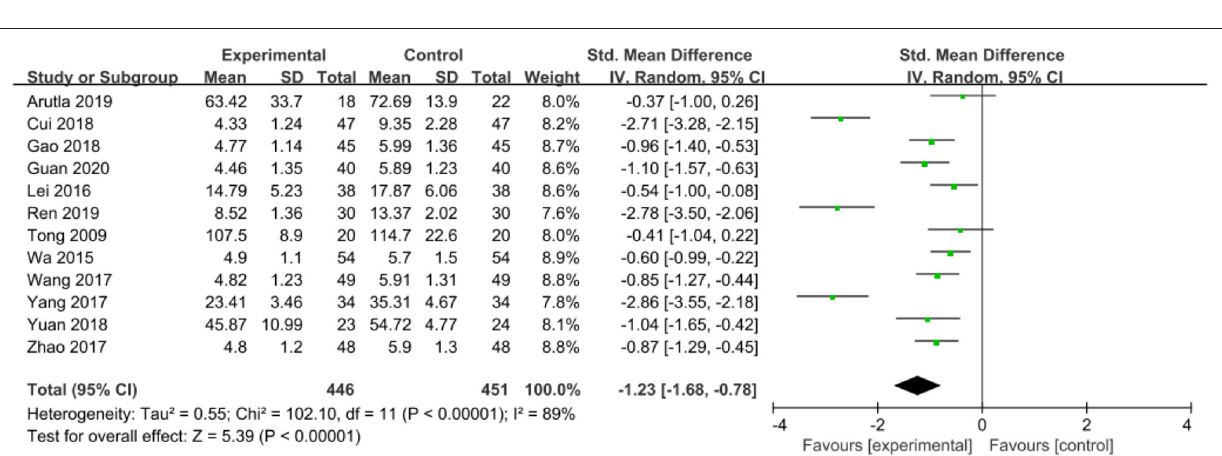
FIGURE 17 | Forest plots of IL-6 associated with experimental group (parenteral or enteral nutrition group supplemented with Gln) vs. control group (conventional nutrition group). I 2 tests and P are the criteria for the heterogeneity test, (cid:7) , pooled standard mean difference; — (cid:4) —, standard mean difference, and the edges of (cid:7) , 95%